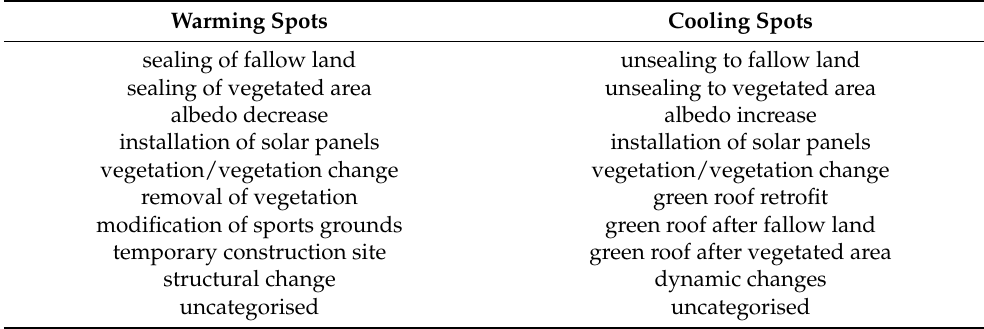
Table 1. Overview of the categories used to classify and label land cover changes that occurred at the spots with extreme surface urban heat island (SUHI) change between 2004–2008 and 2016–2020 in